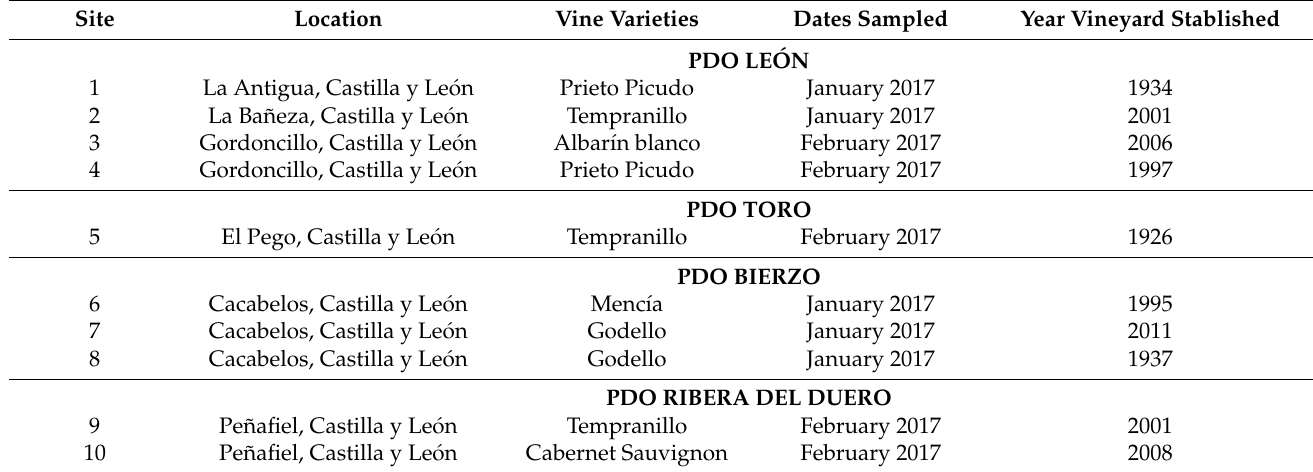
Table 1. Places and code of the soil sampling used for this